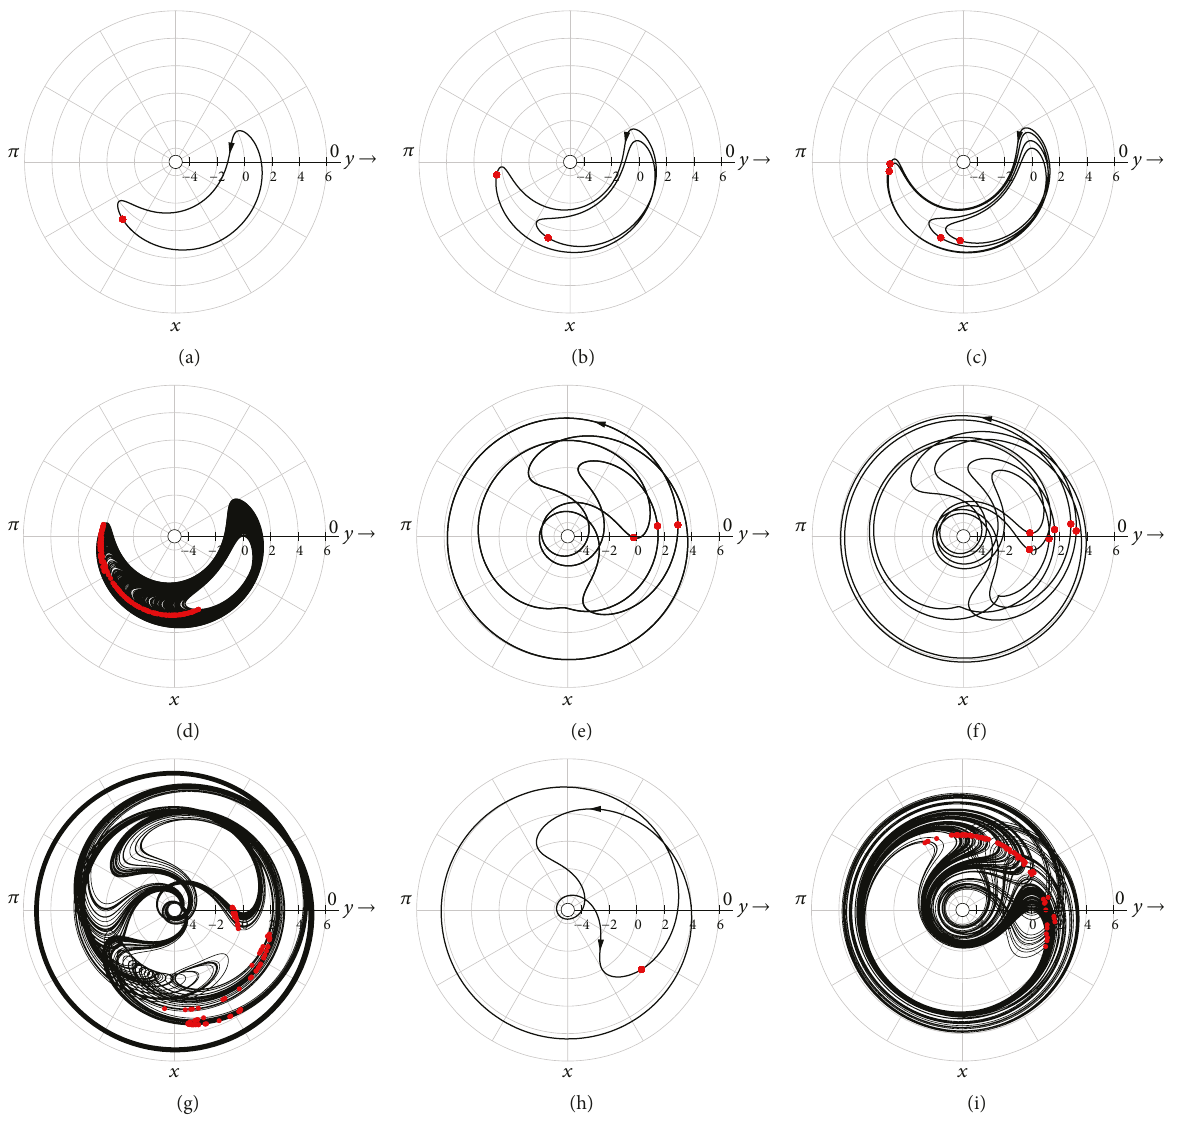
Figure 5: Trajectories of system (3) with 𝑓(𝑦) = 𝑓 1 (𝑦) . The parameters and initial conditions are in (20), 𝐵 0 = 0.5𝜋 , and (a) 𝐵 = 0.50 , 𝑥 = (3.966,0.681) , (b) 𝐵 = 0.60 , 𝑥 0 𝑥 = (−0.018,−0.207 , (f) 𝐵 = 1.45 , 𝑥 0 𝐵 = 2.35 , 𝑥 = (−0.122,1.778) . 0